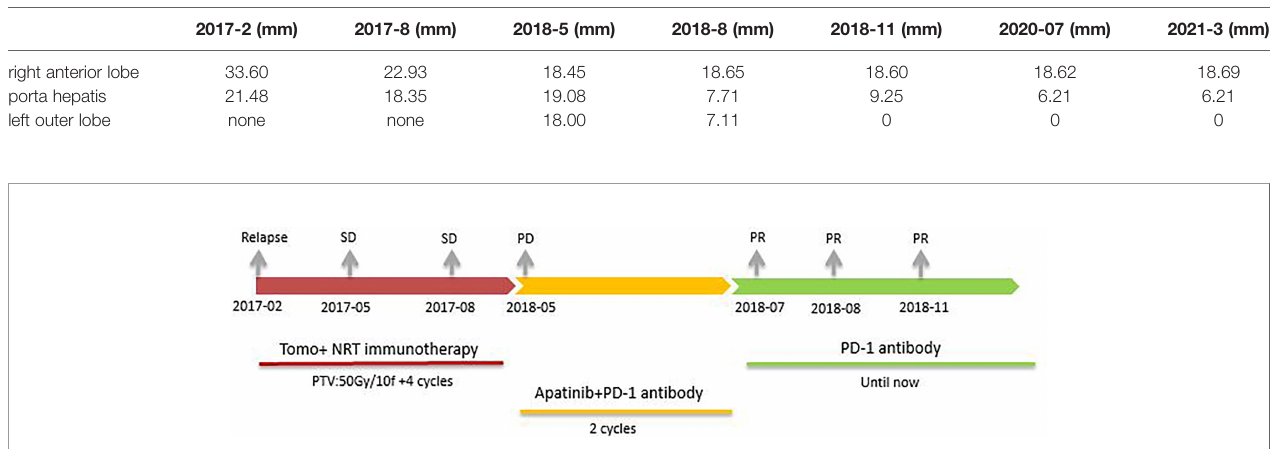
TABLE 2 | The target lesion changes at different time points during and after the treatment.